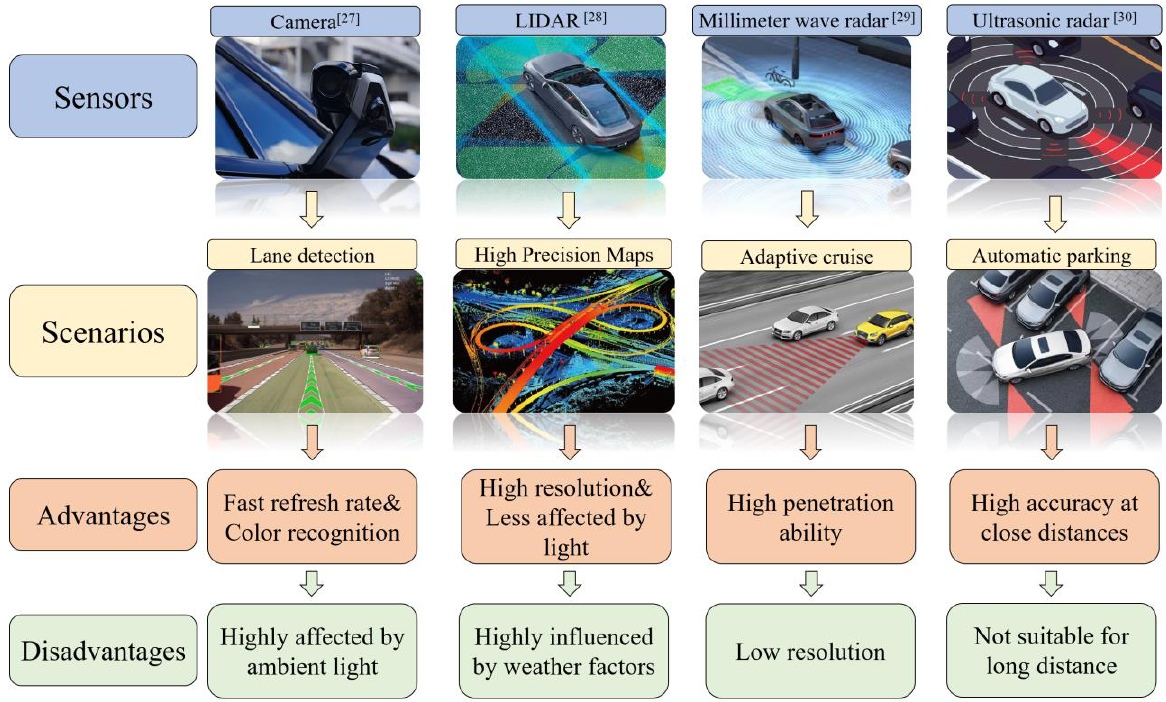
Figure 3. The characteristics of several sensors.